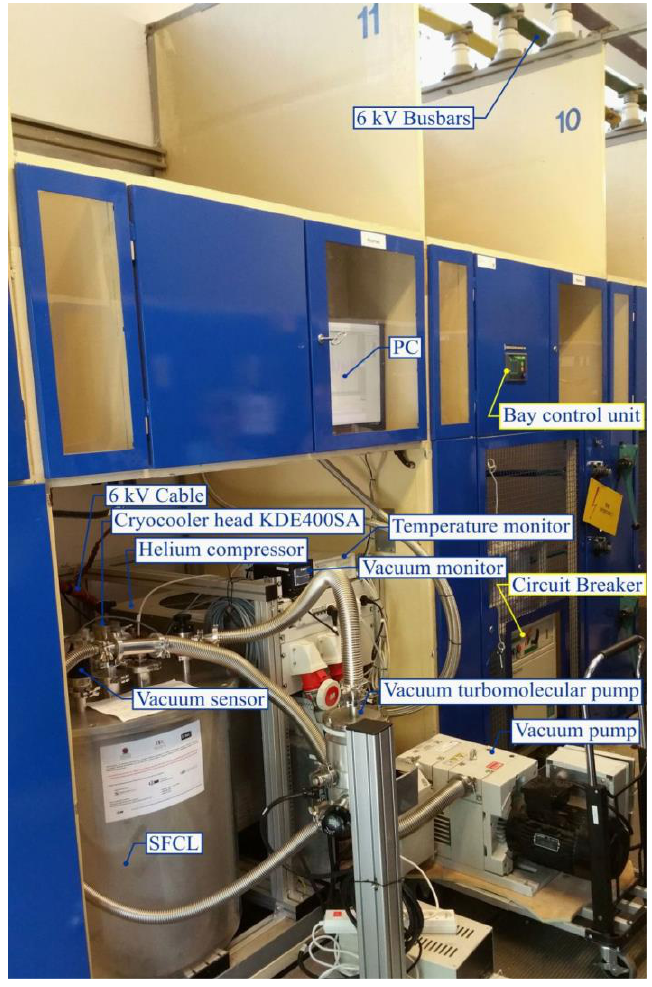
Figure 1. Resistive superconducting fault current limiter